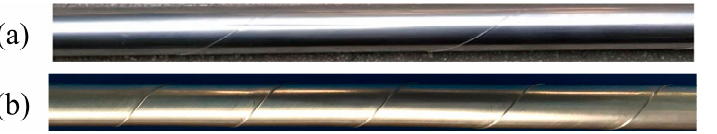
Figure 3. Physical pictures of STACERs obtained by ( a ) CSPB method and ( b ) winding and stabilization method.